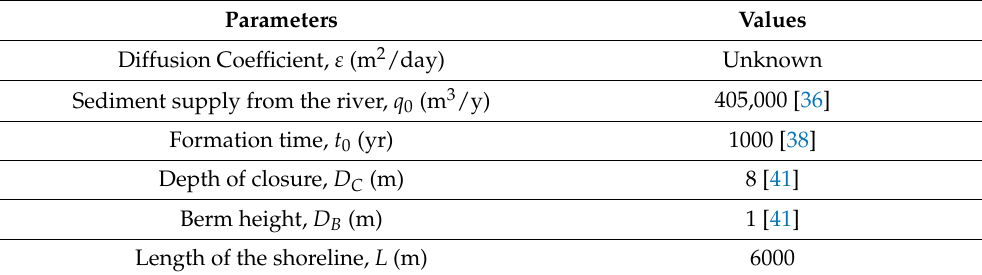
Table 2. Initial values for the calibration condition.